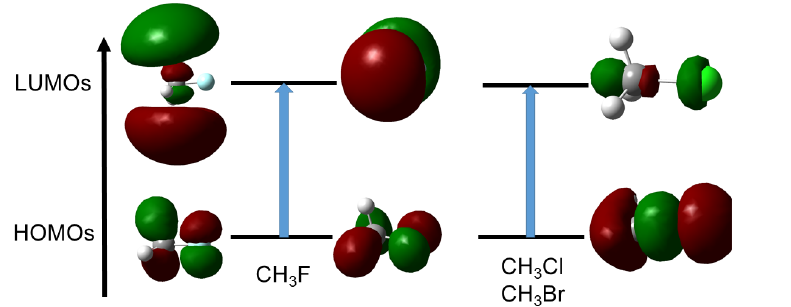
Figure 8. Orbitals involved in the density polarisation of CH 3 F ( left ) and CH 3 Cl ( right ). CH 3 Br follows the same pattern as CH 3